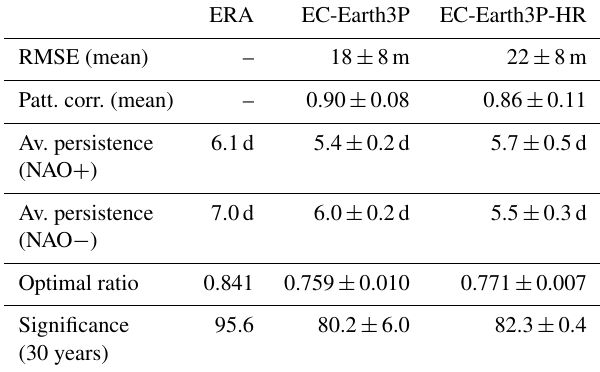
Table 3. Some metrics to assess the overall performance in hist- 1950 of the EC-Earth3P and EC-Earth3P-HR simulations in terms of weather regimes. The table shows the average root mean square error (RMSE) from the observed patterns and the relative average pattern correlation among all regimes, the average persistence of the two NAO states in days, the optimal ratio and the sharpness. The errors refer to the spread between members (standard